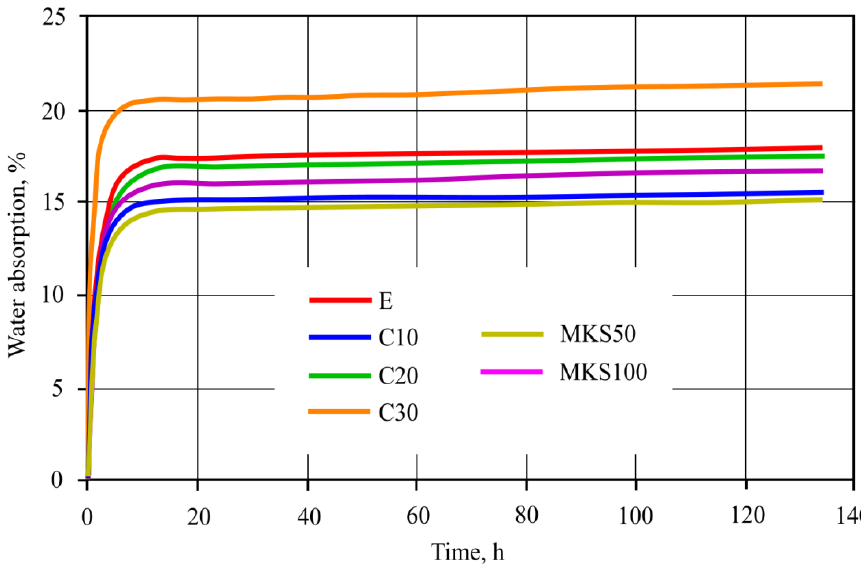
Figure 10. Sample water absorption results.